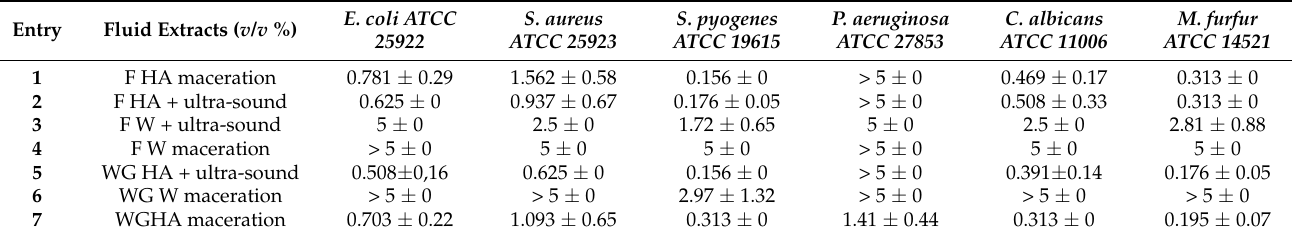
Table 6. Results of MIC assay expressed in v/v